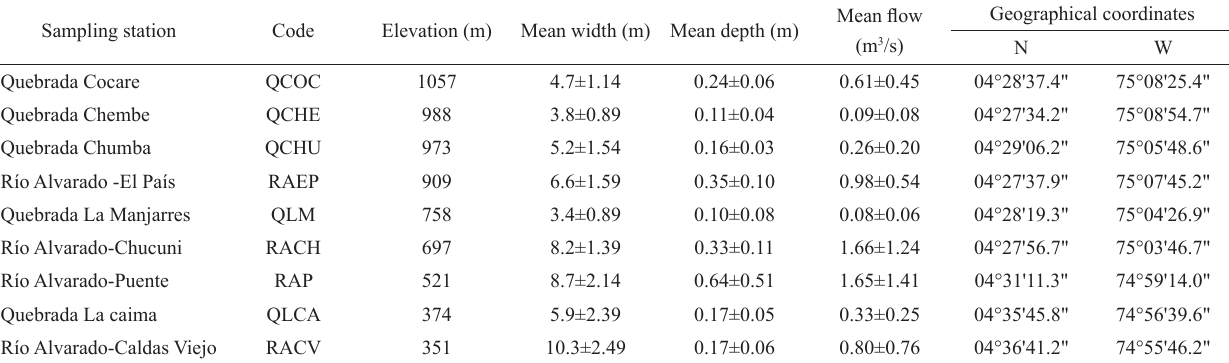
Tab. 1. Physical and spatial characteristics in the sampling sites in the trans-Andean Alvarado River drainage, Upper Magdalena River Basin,